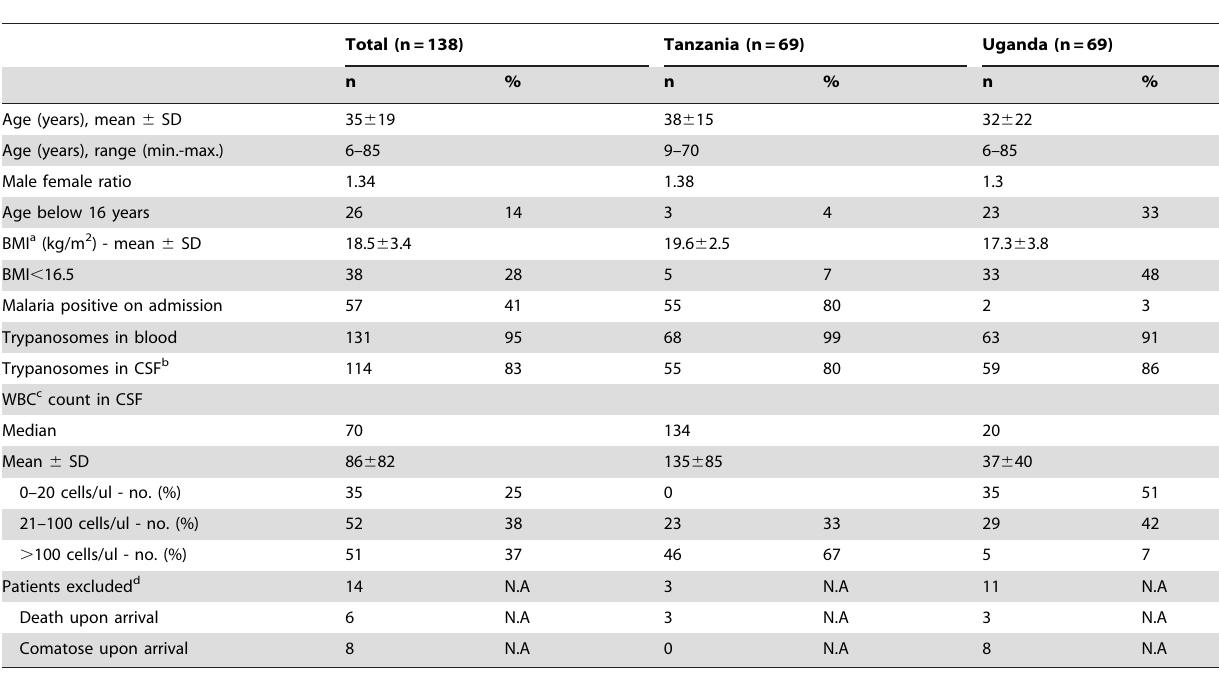
Table 2. Demographic and diagnostic baseline